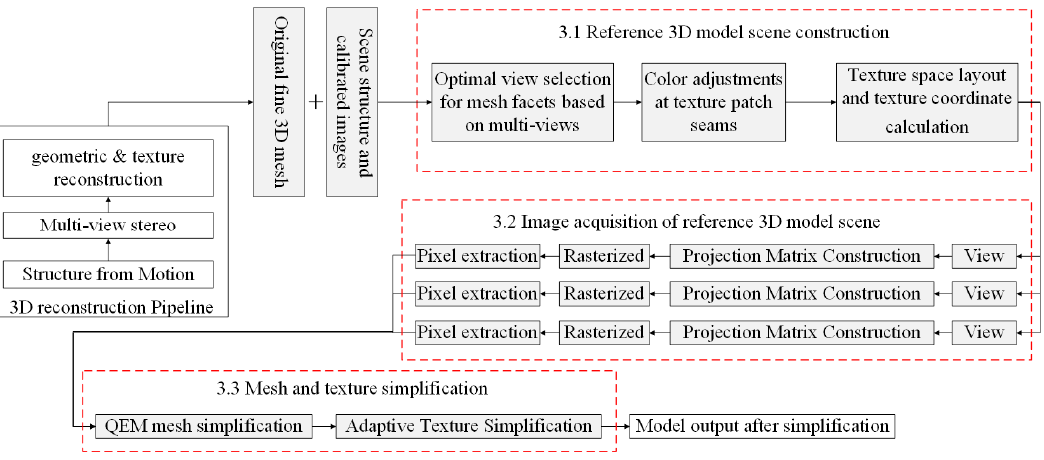
Figure 3. Flowchart of this method.